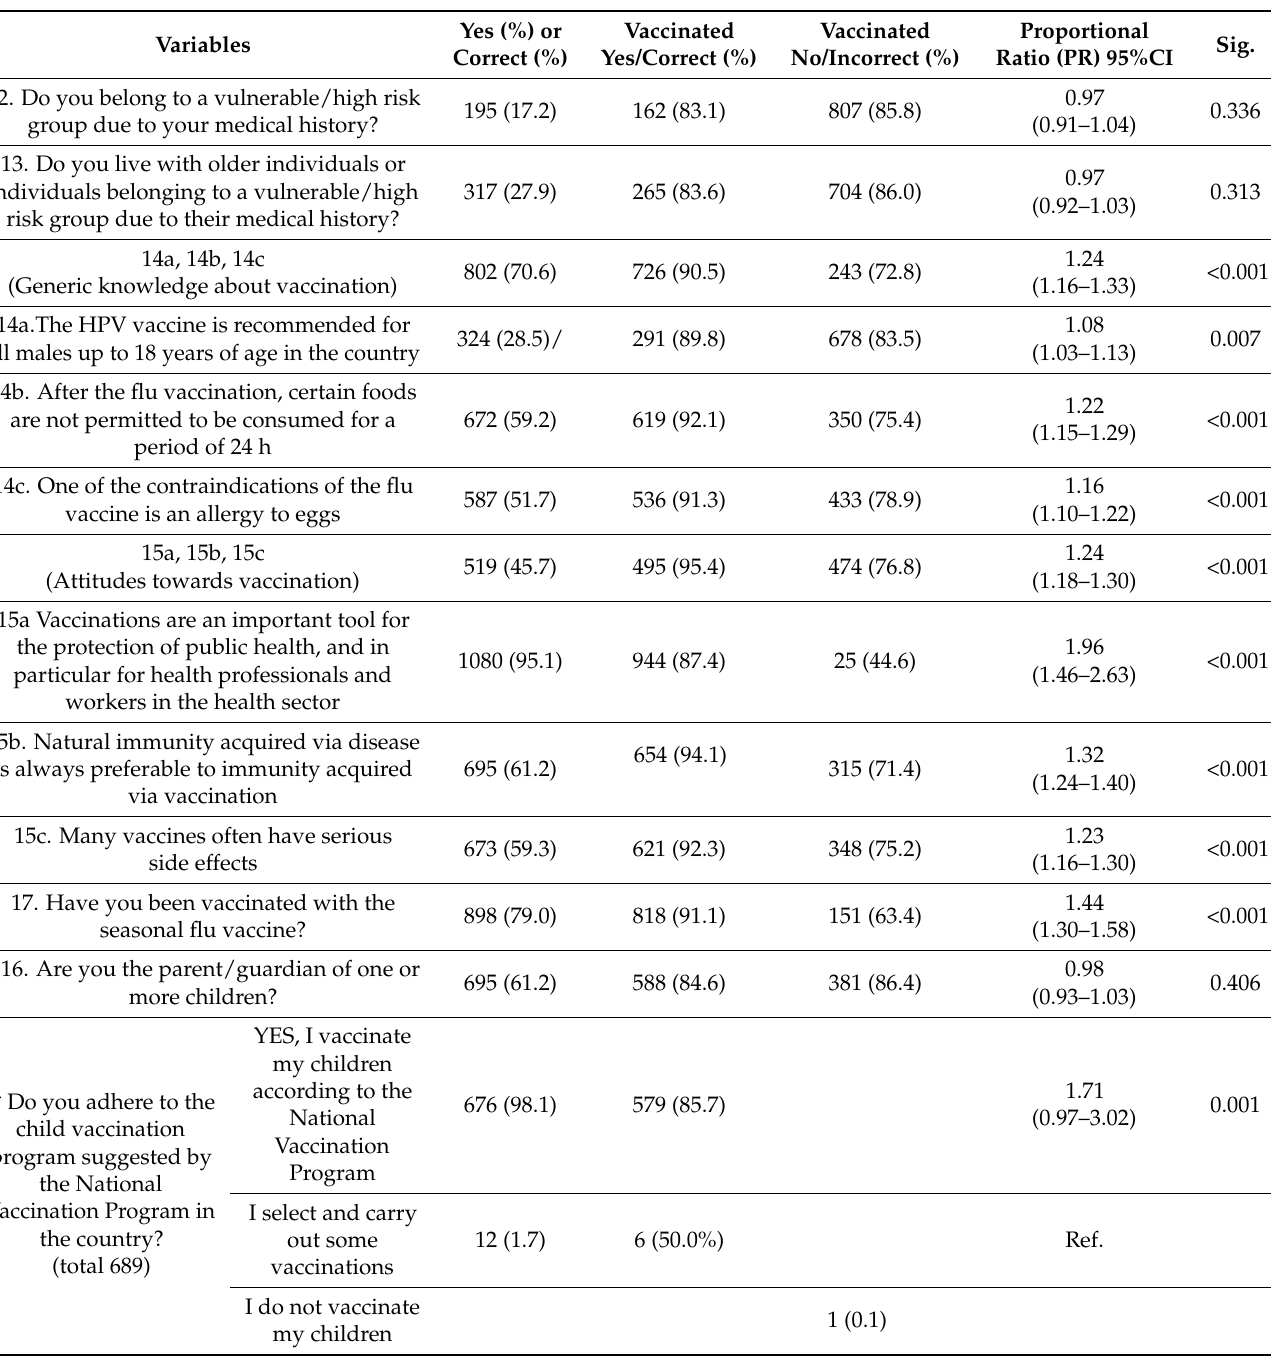
Table 2. Univariate analysis of the generic knowledge and attitudes towards vaccines and COVID-19 vaccine acceptance (Section A) (N =